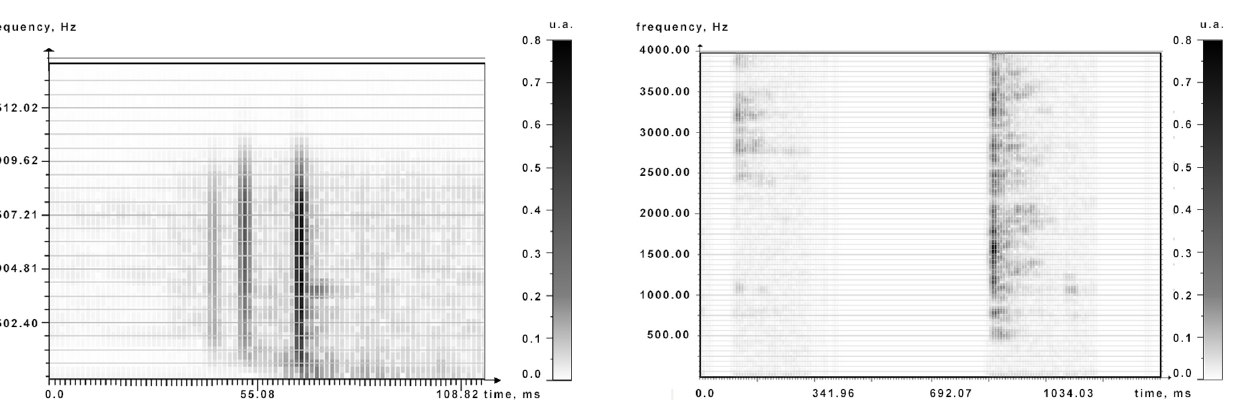
Figure 7. An EM signal registered during the quartz sample frac- turing.